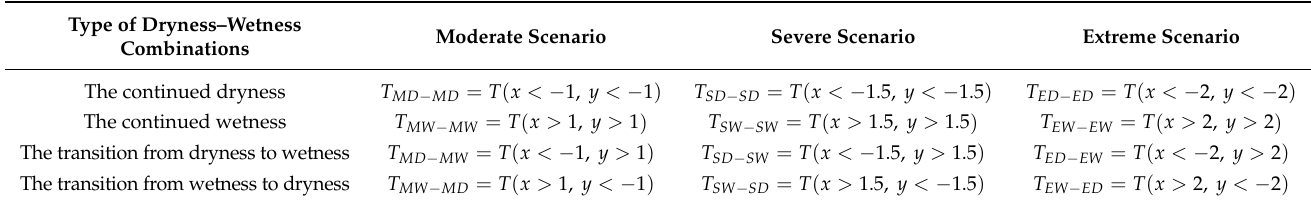
Table 3. Joint return periods of dryness–wetness combinations under three severity